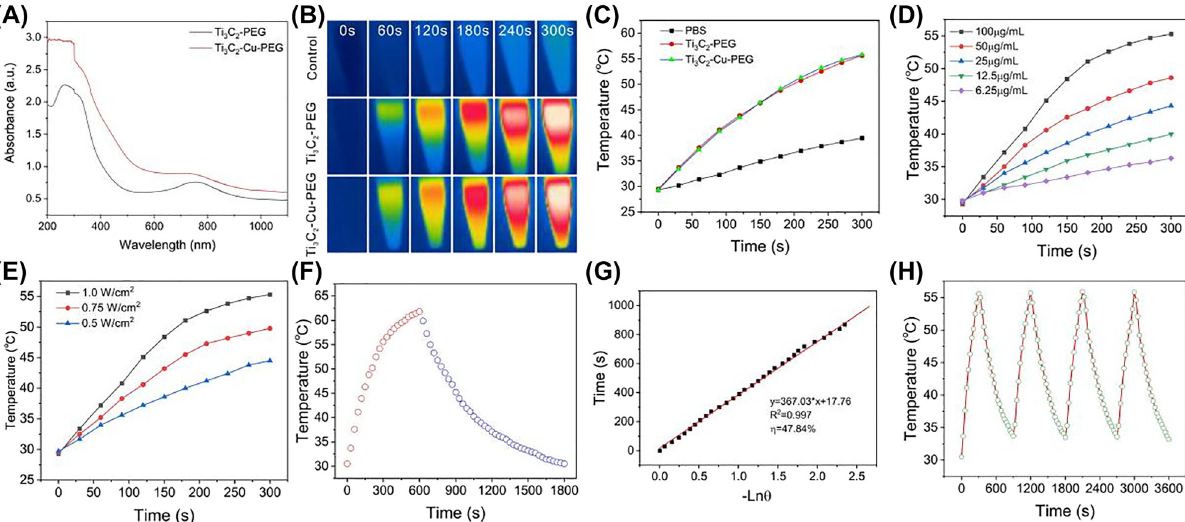
C -Cu-PEG. (A) UV-vis-NIR absorption spectra of Ti Figure 2: Photothermal performance of the Ti 3 2 C -Cu-PEG aqueous solution (100 μ g/mL), Ti Infrared thermal images of the Ti 3 2 laser with a power density of 1 W/cm 2 for 5 min. (C) Temperature variation curves versus irradiation time for Ti C -PEG aqueous solution (100 μ g/mL) and PBS under laser irradiation (1064 nm, 1 W/cm 2 ). (D) Temperature variation curves (100 μ g/mL), Ti 3 2 C -Cu-PEG aqueous solution with different concentrations under 1064 nm laser irradiation at 1 W/cm 2 . (E) Temperature variation for Ti 3 2 C -Cu-PEG aqueous solution under varied irradiation powers (0.50, 0.75 and 1 W/cm 2 ) at concentration of 100 μ g/mL. (F) curves of Ti 3 2 C -Cu-PEG aqueous solution irradiated with a 1064 nm laser (1 W/cm 2 ), in which the irradiation lasted for 600 s, Photothermal effect of Ti 3 2 and then the laser was shut off. (G) Linear time data versus -Ln θ obtained from the cooling period as shown in (F). (H) Recycling-heating C -Cu-PEG solution under 1064 nm laser irradiation at 1 W/cm 2 for four laser on/off cycles. profiles of the Ti 3 2